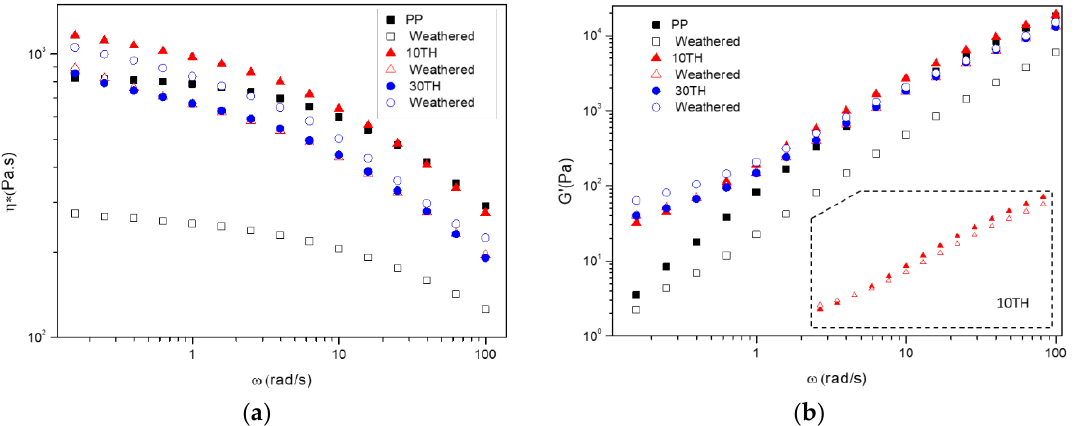
Figure 9. A comparation of ( a ) complex viscosity η* and ( b ) loss modulus G′ of initial and weathered PP, 5TH and 30TH.